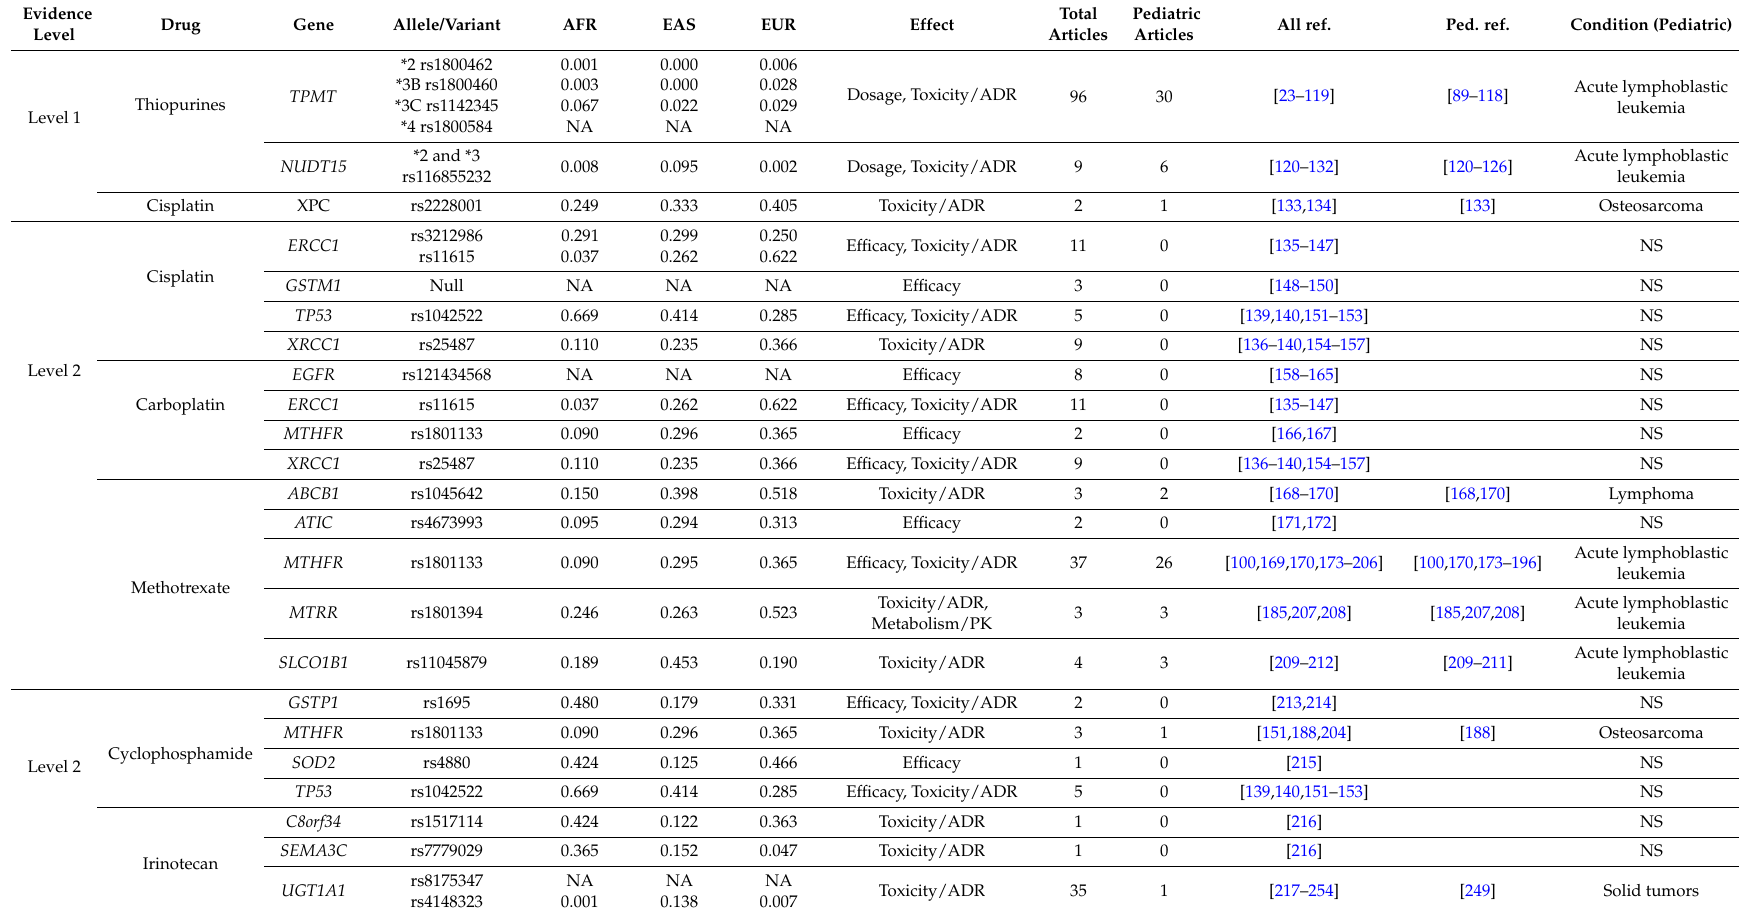
Table 1. Gene–drug pairs with high and moderate (Group 1 and 2) evidence of association as graded by